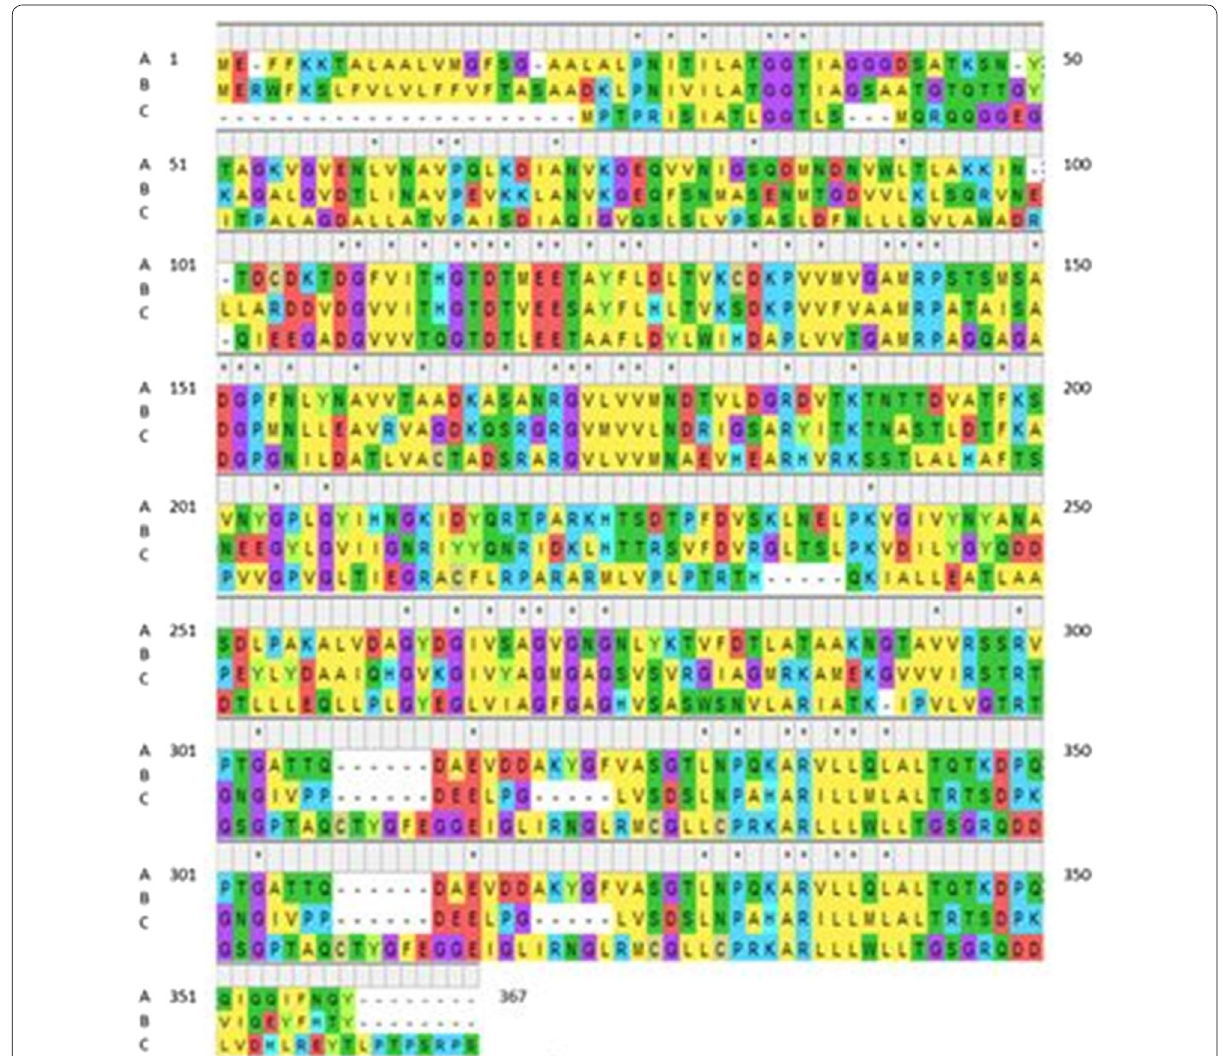
Fig. 2 Amino acid sequences alignment of l -asparaginase of Stenotrophomonas maltophilia ( c ) relative to that of E. coli B354 ( a ) and Erwinia chrysanthemi ( b